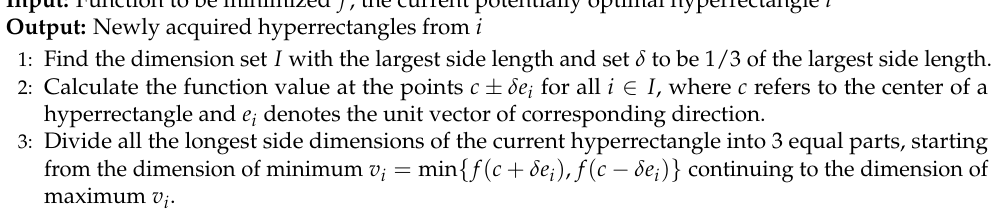
Algorithm 1 Procedure for hyperrectangle partition